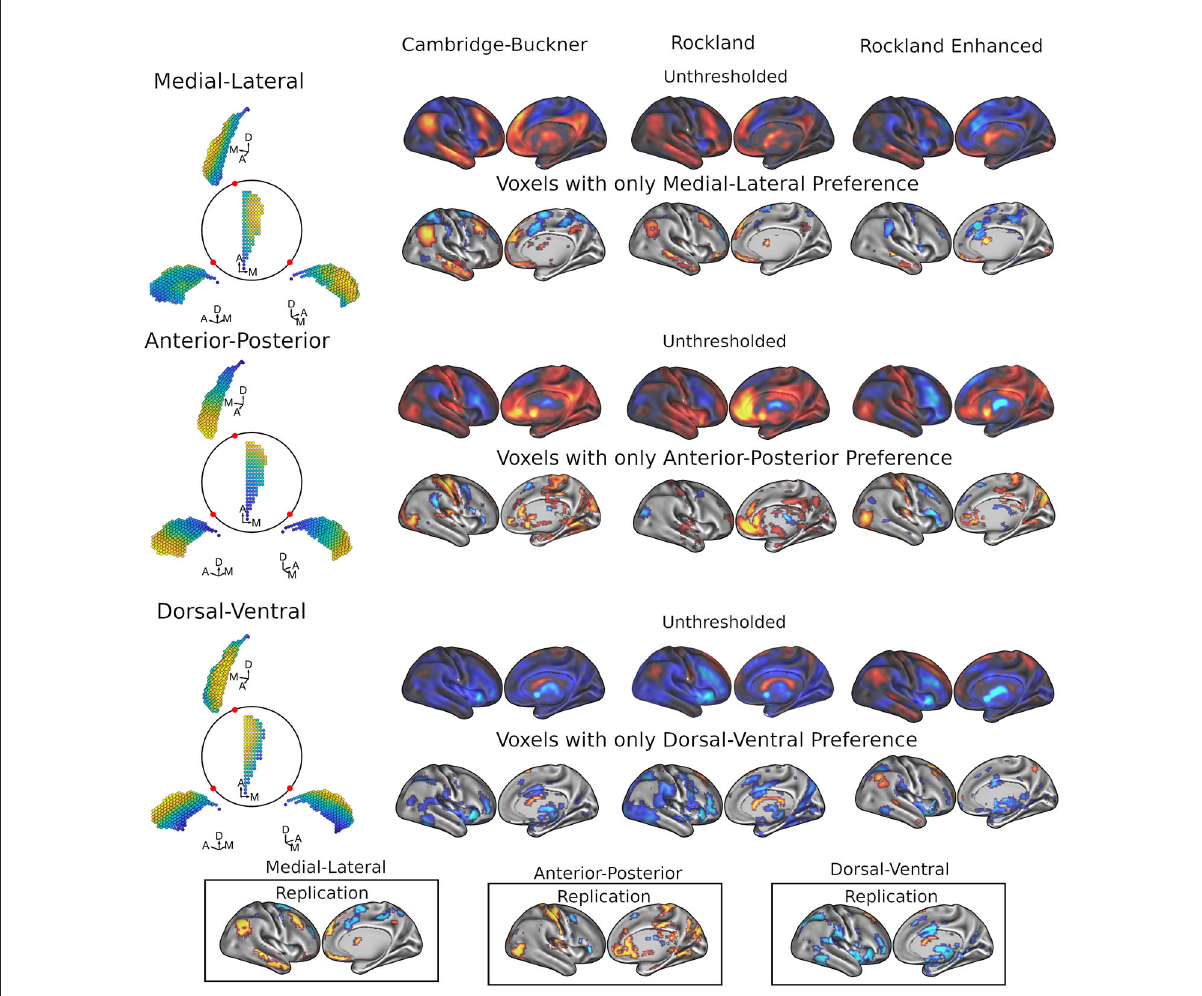
FIGURE2 Results of FiRST analysis on caudate functional connectivity across 3 datasets: Cambridge-Buckner, Rockland, and Rockland Enhanced. For each data sample, we calculated the spatial betas uniquely related to each of the three spatial dimensions of caudate, which are orthogonalized: M-L, A-P, and D-V. For each caudate gradient (illustrated on the left from different viewpoints of the right caudate), the unthresholded (first rows) and thresholded (second rows) maps show the associated cortical areas while controlling for the other two dimensions. In the bottom panels, we calculated the replication maps across the three data samples, where a voxel was maintained if it surpassed threshold in 2/3 data samples. Color code: warmer colors represent more medial, anterior, and dorsal connectivity, whereas cooler colors represent more lateral, posterior, and ventral connectivity with the caudate for the M-L, A-P, and D-V axis,